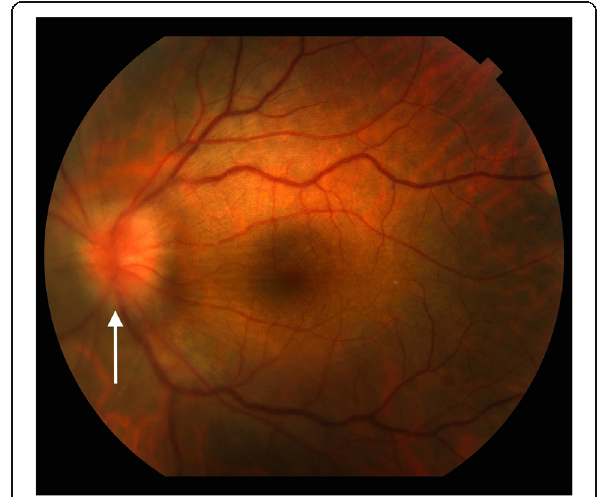
Fig. 1 Fundus color picture of tertiary syphilis: note the optic nerve swelling (white